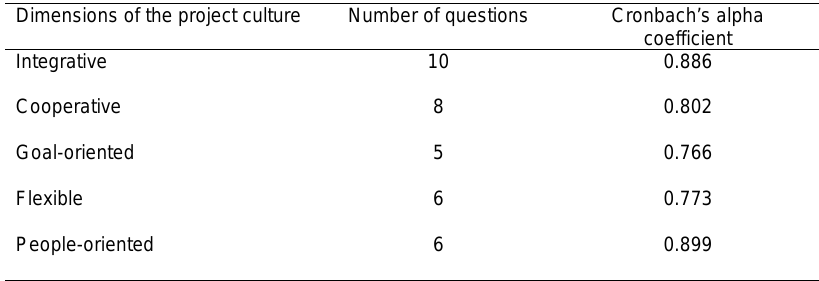
Table 3: Reliability of internal consistency